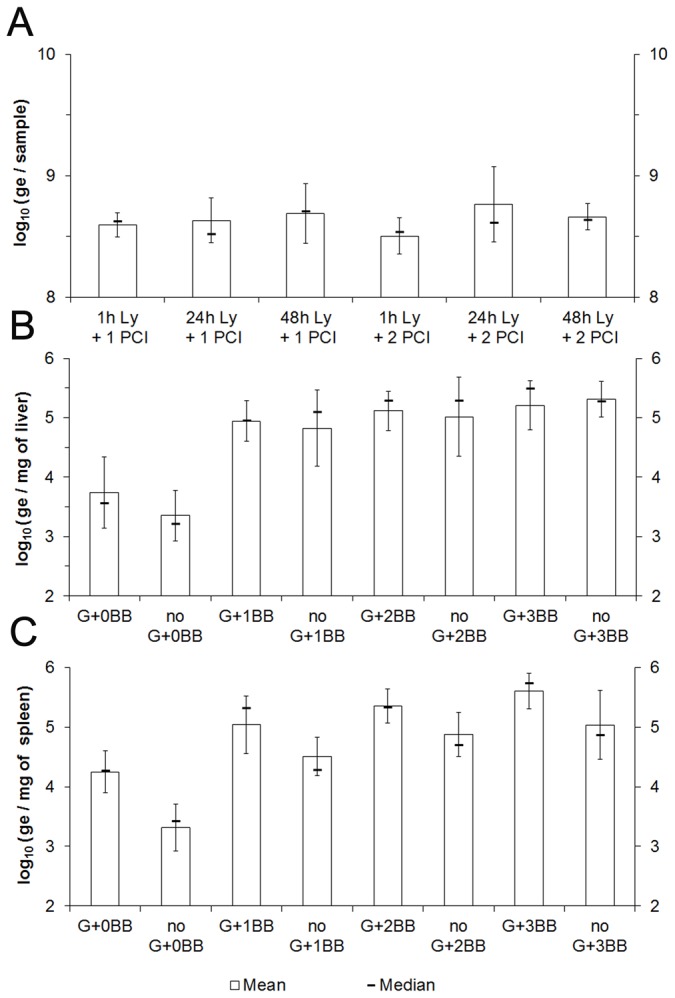
Comparison of MAP K-10 quantification methods in culture samples (A, n=28), or in liver (B, n=45) and spleen (C, n=45) samples from C57BL/6 mice: culture on 7H10-mycobactin versus TaqMan real-time PCR targeting MAP0865 gene, including 1 h, 24 h, or 48 h of lysozyme digestion (Ly), 1 or 2 phenol:chloroform:isoamyl purifications (PCI), no or 1 grinding step (G), and/or 0, 1, 2 or 3 steps of bead beating (BB) during DNA extraction procedure.Error bars are standard deviation.